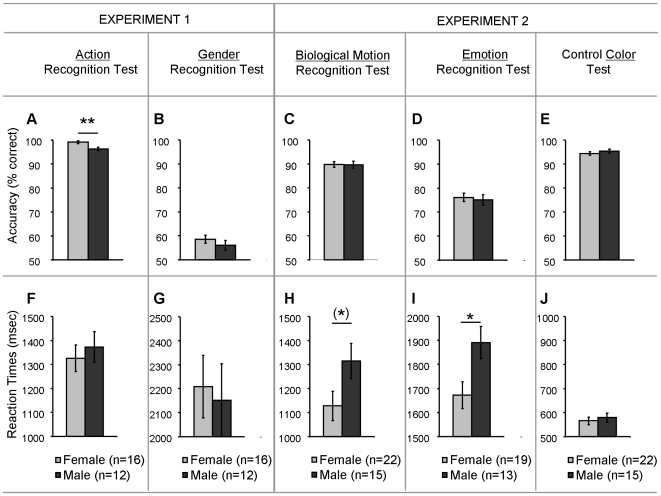
Gender differences in test performance.Accuracy (% correct scores) (A–E) and Reaction times (F–J) are displayed as a function of participant group (male, female) separately for each test of experiment 1 [Action Recognition Test (A, F); Gender Recognition Test (B, G)] and experiment 2 [Biological motion Recognition Test (C, H); Emotion Recognition Test (D, I); Control Color Test (E, J)]. Vertical lines denote ±standard error. [(*) p = .05; * p<.05; ** p<.01].